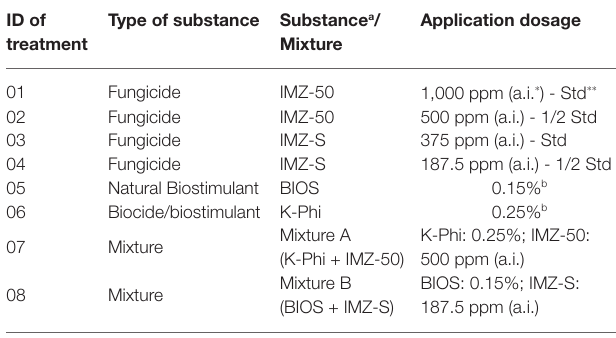
TABLE 1 | List of substances and mixtures used in this study. ID of Type of substance Substance a / Application treatment Mixture